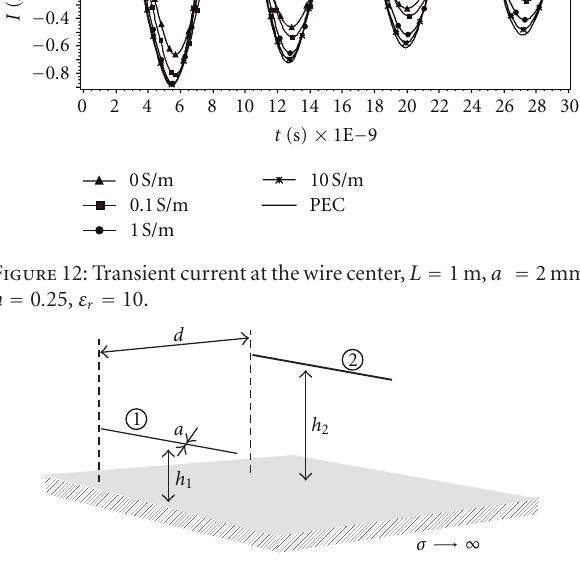
Figure 13: Geometry No. 1: Two-wire array above a PEC ground ( a = 2cm, L = 10m, d = 1m, h 1 = 1m, and h 2 =